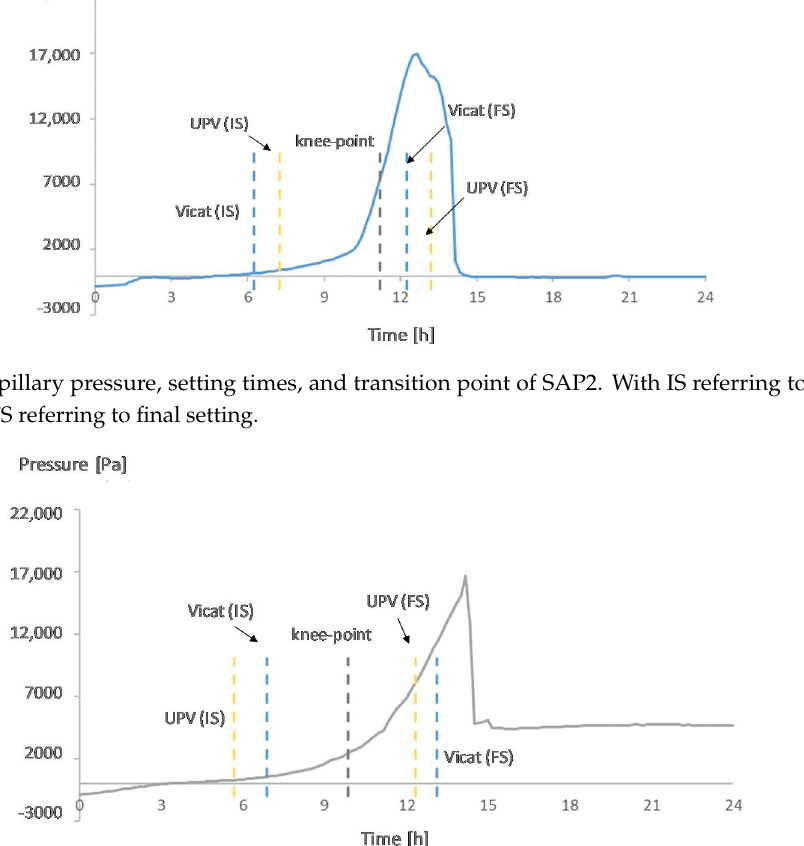
Figure 10. Capillary pressure, setting times, and transition point of REF0.354. With IS referring to initial setting and FS referring to final setting.